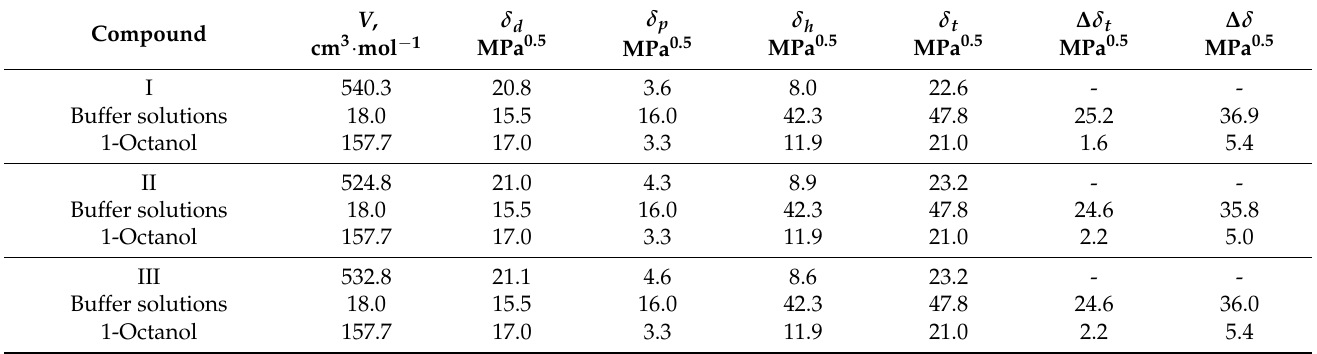
Table 3. Molar volumes and Hansen solubility parameters for compounds I–III and selected